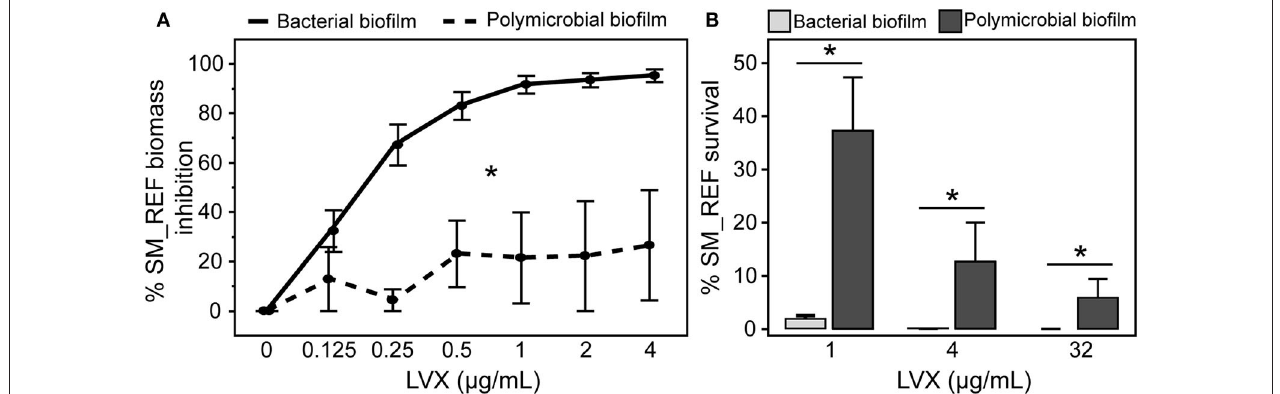
FIGURE 5 | Effects of levofloxacin on SM_REF in bacterial and polymicrobial biofilms. (A) Assessment of LVX activity on SM_REF in bacterial (solid line) and polymicrobial (broken line) biofilms by qPCR. (B) Percentages of SM_REF survival following LVX (1, 4, and 32 µ g/mL) treatment in bacterial (light gray) and polymicrobial (dark gray) biofilms using viable plate count. * p < 0.05; LVX, levofloxacin.